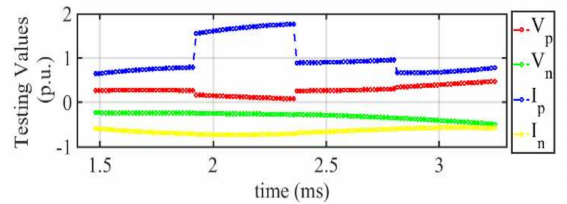
Figure 30. Testing values of the SVM algorithm under PPG